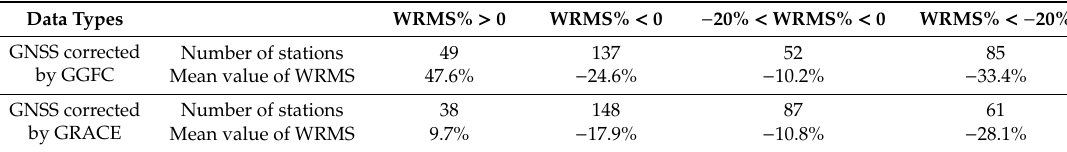
Figure 6. Weighted root mean square (WRMS) reduction ratio by correcting GNSS VDs with loading from GRACE (upper panel) ( a ) and GGFC (bottom panel) ( b ). Table 2. Statistical results for the WRMS reduction.